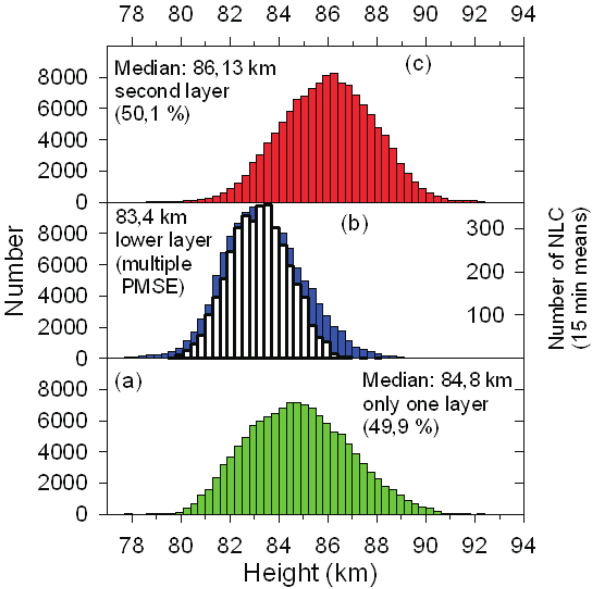
Fig. 3. Histogram of the preferred centroid heights of PMSE and NLC (1997–2004): (a) for PMSE with only one layer; (b) for the lower layer of PMSE in the case of multiple PMSE layer structures (blue) together with the centroid heights of NLC (white ); and (c) for the second layer in the case of multiple PMSE layer structures.